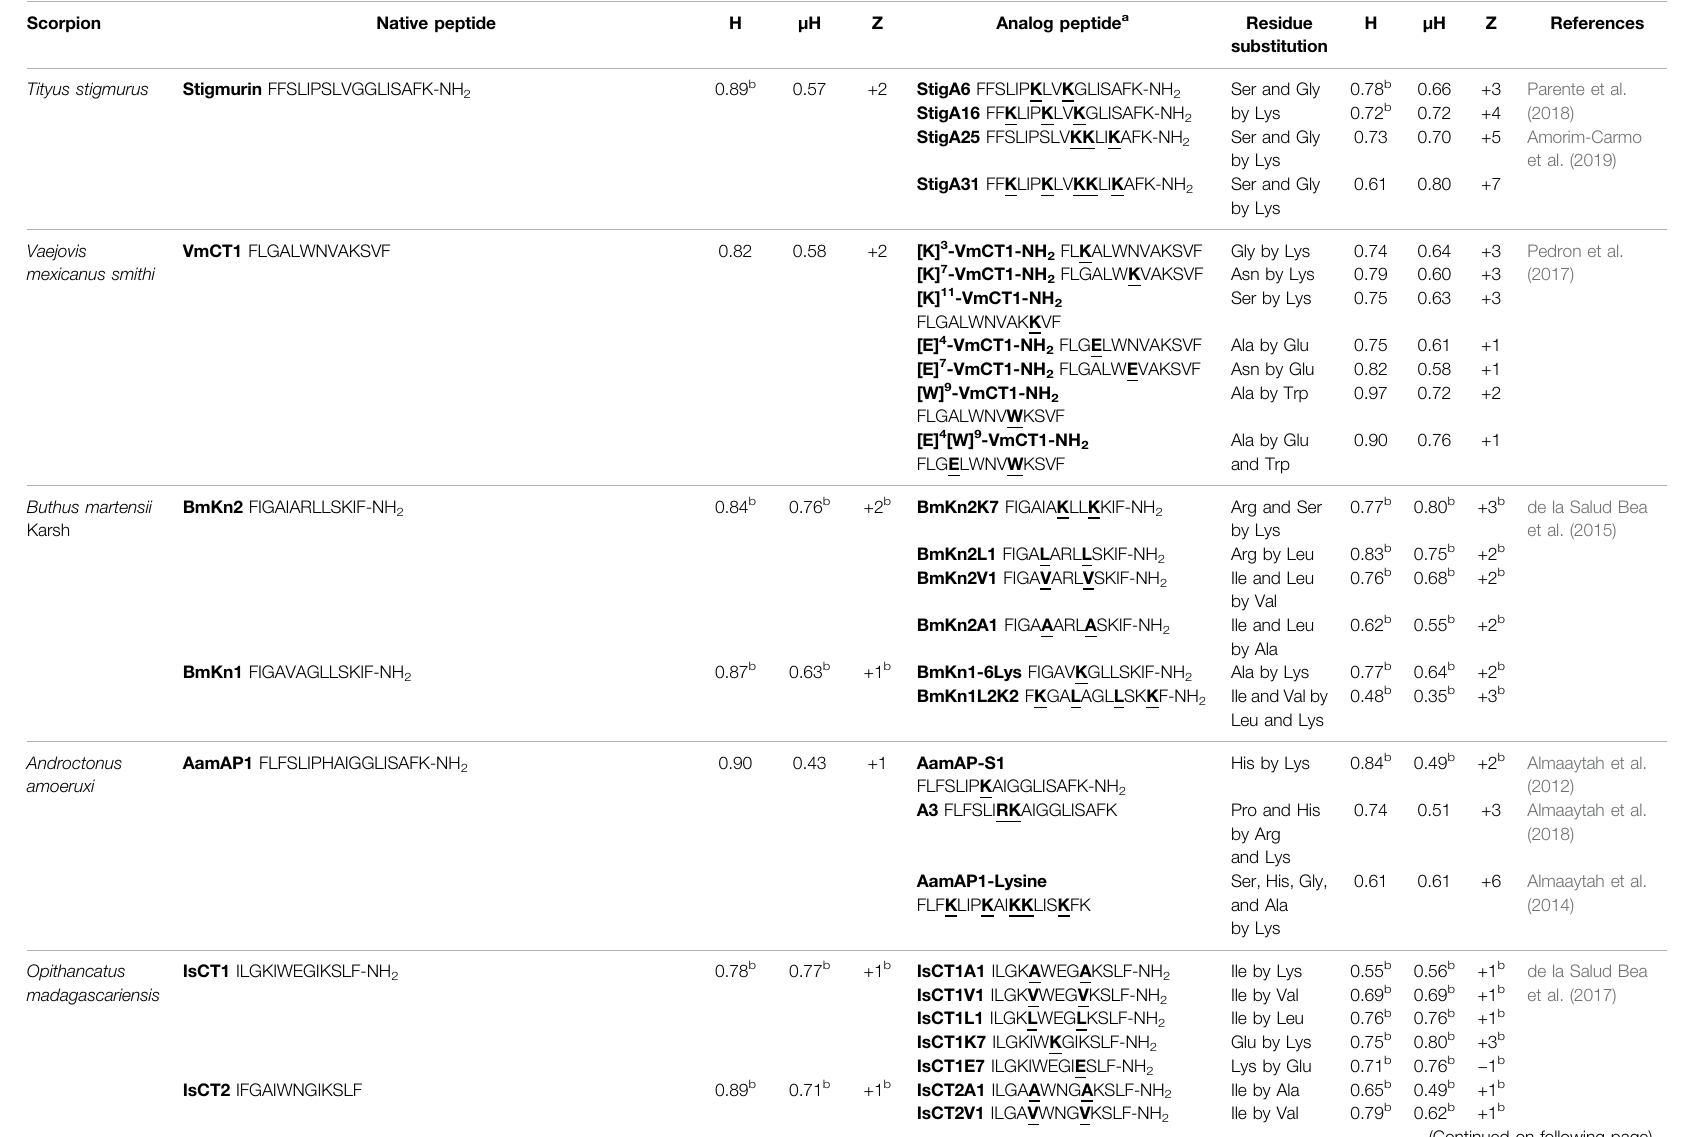
TABLE 1 | Physicochemical characteristics of native antimicrobial peptides and scorpion